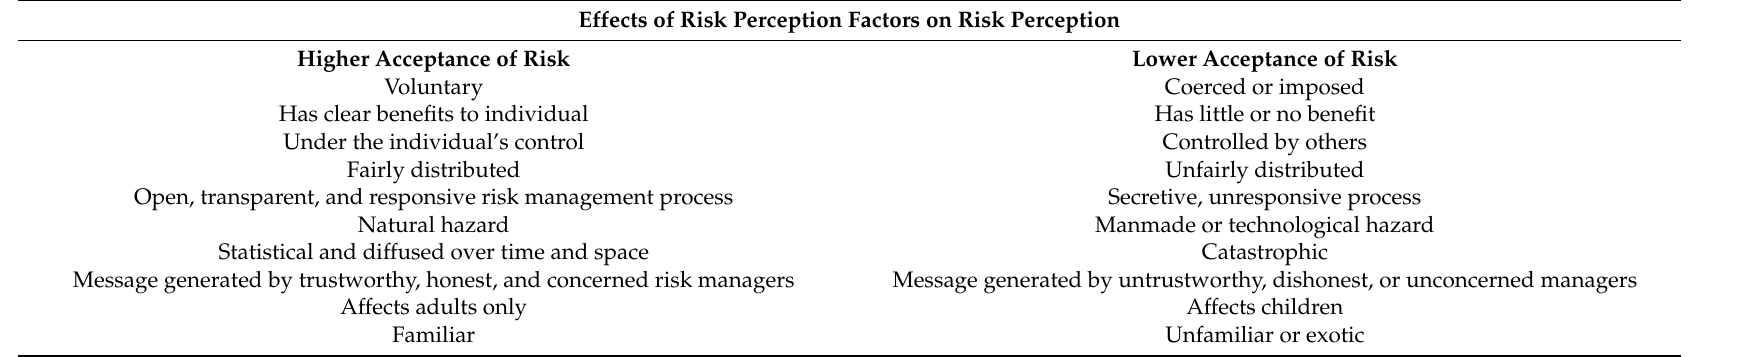
Table A2. Effects of risk perception factors on risk perception (adapted from